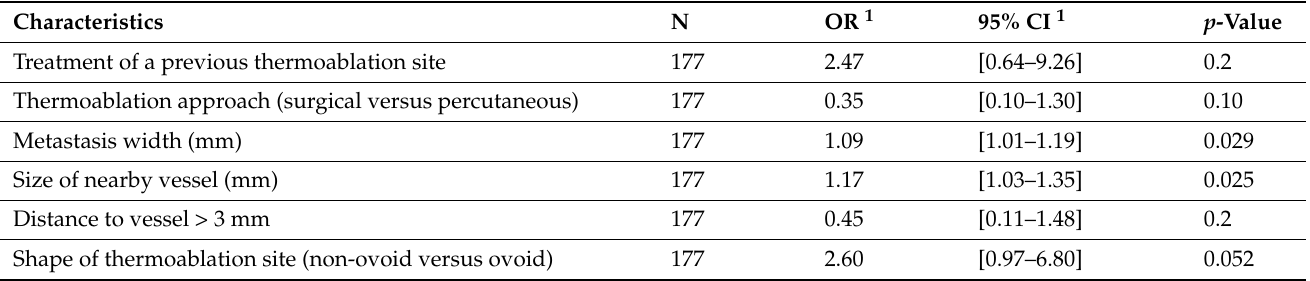
Table 6. Relation between characteristics chosen by LASSO logistic regression and local